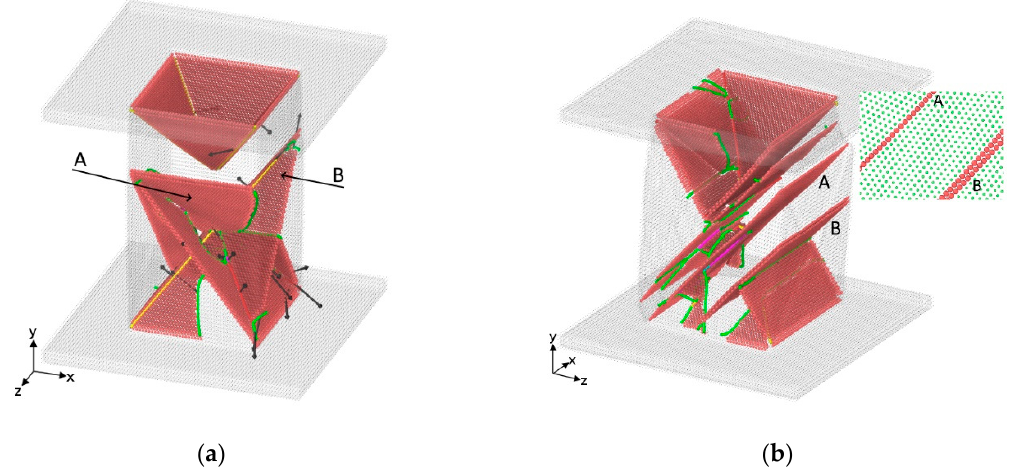
Figure 4. Shear in a < 001 > single crystal with h / d = 2 and {110} lateral faces at a sequentially increasing strain of ( a ) 13.8%; ( b ) 16.9%. A and B in ( b ) indicate a twin boundary and an intrinsic stacking fault, respectively.